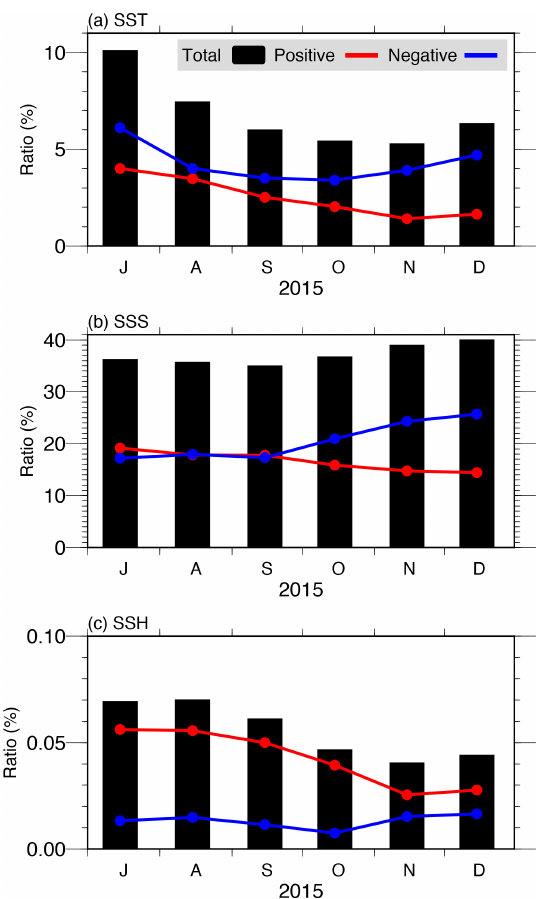
Figure 4. Monthly mean ratio of the area where the AOEI is applied to the system domain in the (a) SST, (b) SSS, and (c) SSH fields in the AOEI run (black bars). Red (blue) lines indicate when the innovation is positive